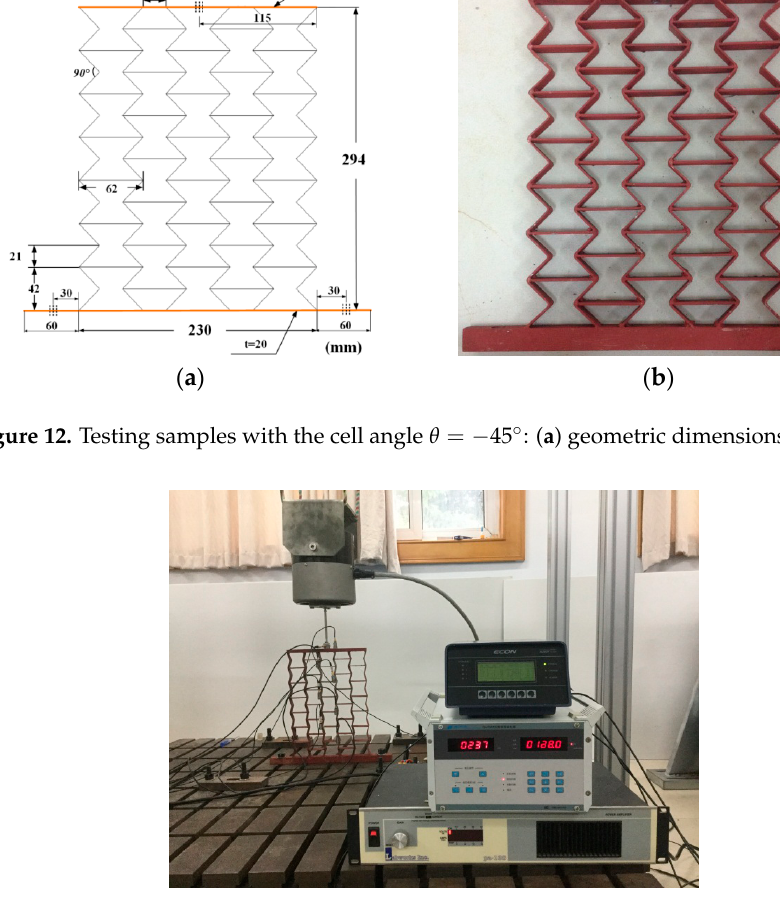
Figure 13. Frequency response experiment of the auxetic honeycombs.